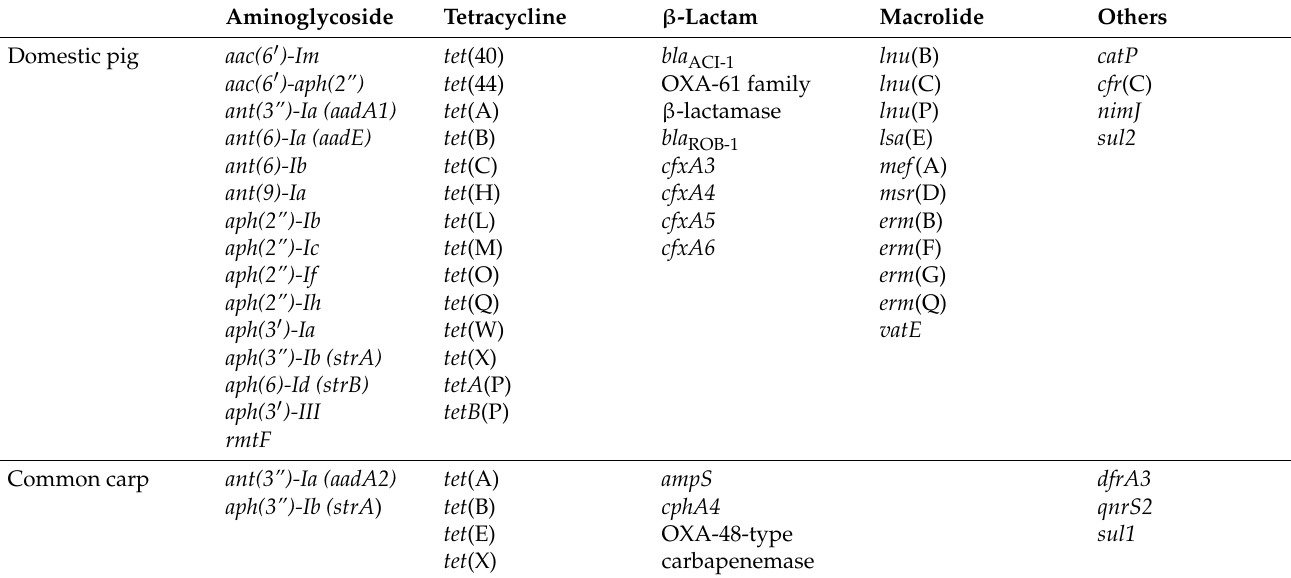
Table 1. Summary of the ARG types detected in domestic pig and common carp intestinal samples from Hungary a .